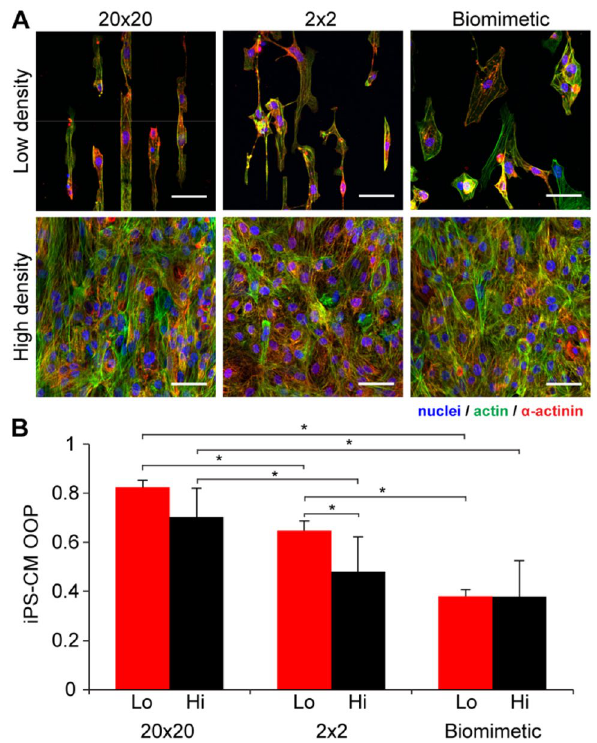
Figure 4. Analysis of iPS-CM adhesion and alignment on the fibronectin micropatterns at low and high cell density. ( A ) Representative images showing pattern-dependent difference in cell morphology at low density (isolated cells) and high density (monolayer). Scale bars are 50 µm. ( B ) OOP analysis of iPS-CMs at low and high cell densities showing that alignment is dependent on both density and pattern type. Note that results for the iPS-CMs are distinctly different than for the chick cardiomyocytes. Two-way ANOVA with Tukey’s posthoc, *indicates p < 0.05, n ≥ 3). Error bars are standard